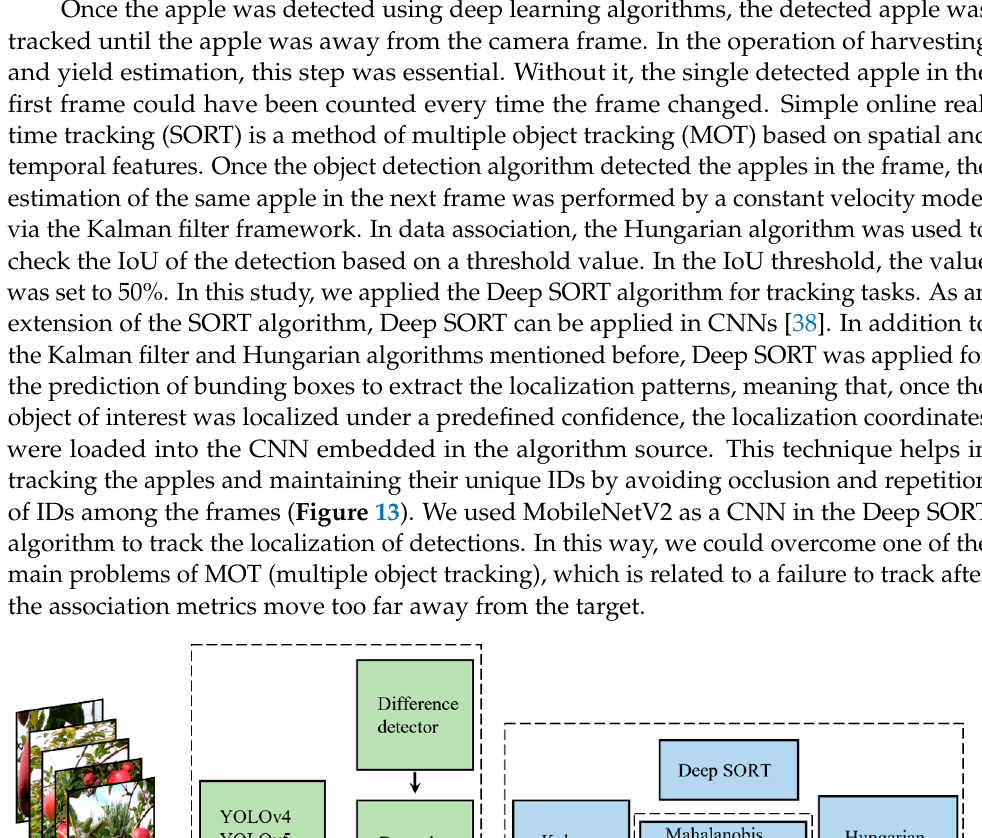
Figure 12. Outdoor experiments using a four-wheel tractor and artificial trees to create a specially designed orchard.